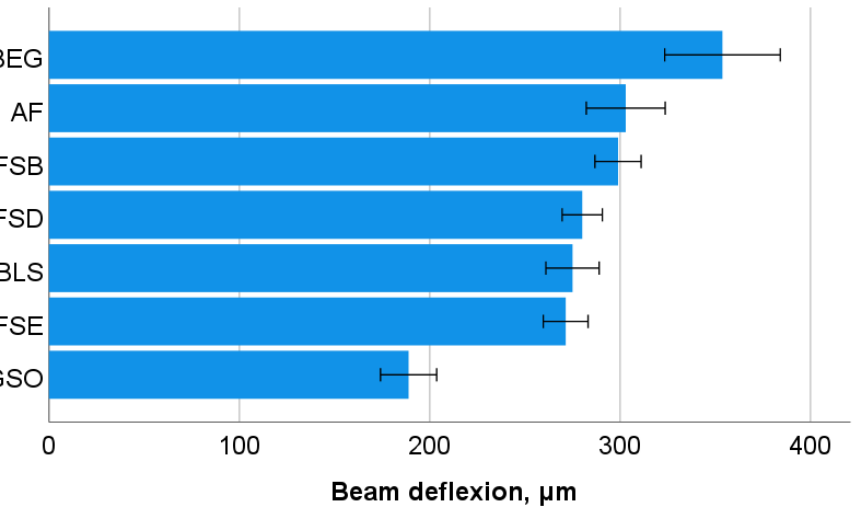
Figure 3. Three-point bending test: beam deflection (mean values with 95% confidence interval). Material abbreviation: AF = Admira Fusion; BEG = Brilliant EverGlow; BLS = Beautifil II LS; FSB = Filtek Supreme XTE Body; FSD = Filtek Supreme XTE Dentin; FSE = Filtek Supreme XTE Enamel; GSO = Grandio SO.